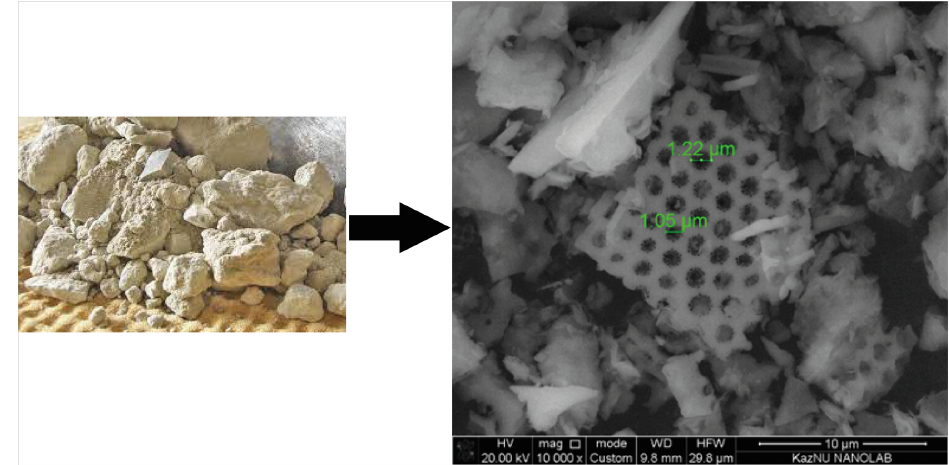
Figure 2. Natural diatomite (Aktobe region, Kazakhstan) and its SEM